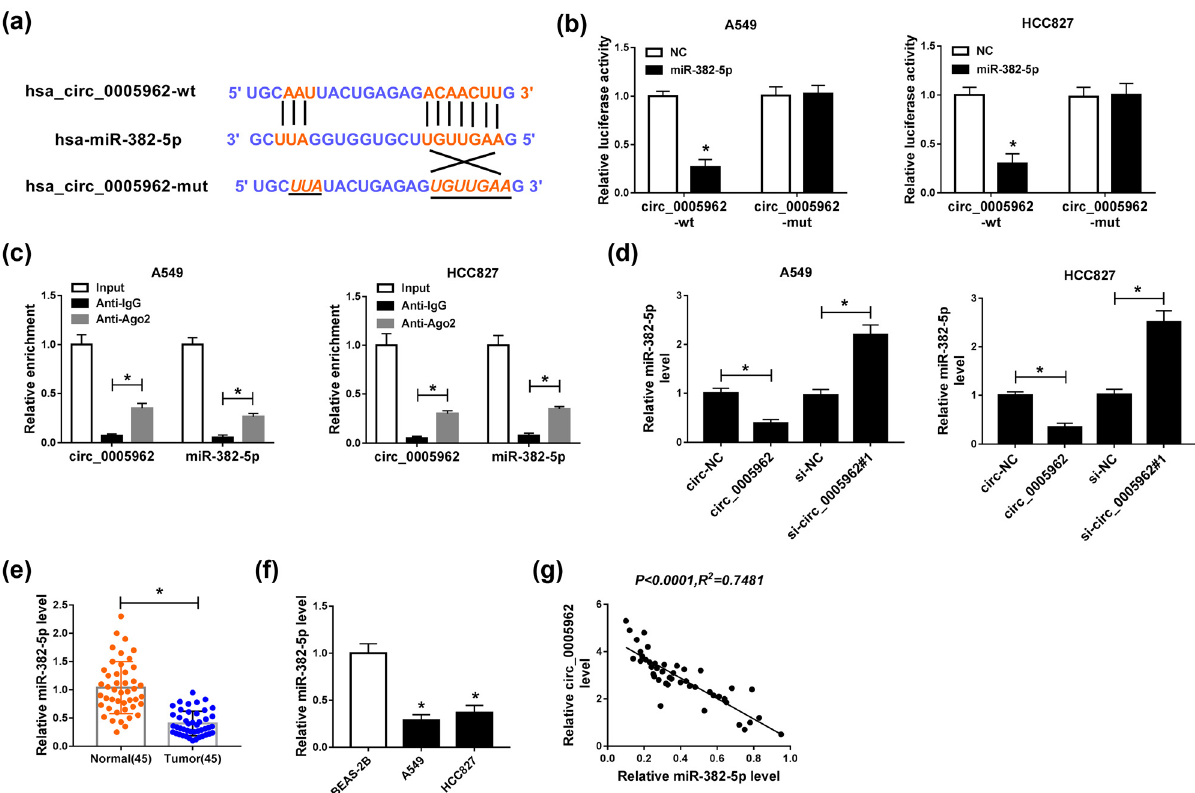
Figure 3: miR - 382 - 5p was a target of circ_0005962. ( a ) The binding sites between circ_0005962 and miR - 382 - 5p were analyzed by the online tool circInteractome. ( b ) The relationship between circ_0005962 and miR - 382 - 5p was veri fi ed by dual - luciferase reporter assay. ( c ) The relationship between circ_0005962 and miR - 382 - 5p was further con fi rmed by RIP assay. ( d ) The expression of miR - 382 - 5p in A549 and HCC827 cells transfected with circ_0005962 or si - circ_0005962 was detected by qPCR. ( e and f ) The expression of miR - 382 - 5p in NSCLC tissues and cell lines was detected by qPCR. ( g ) The correlation between circ_0005962 and miR - 382 - 5p was analyzed by Spearman ’ s correlation coe ffi cient. * P <